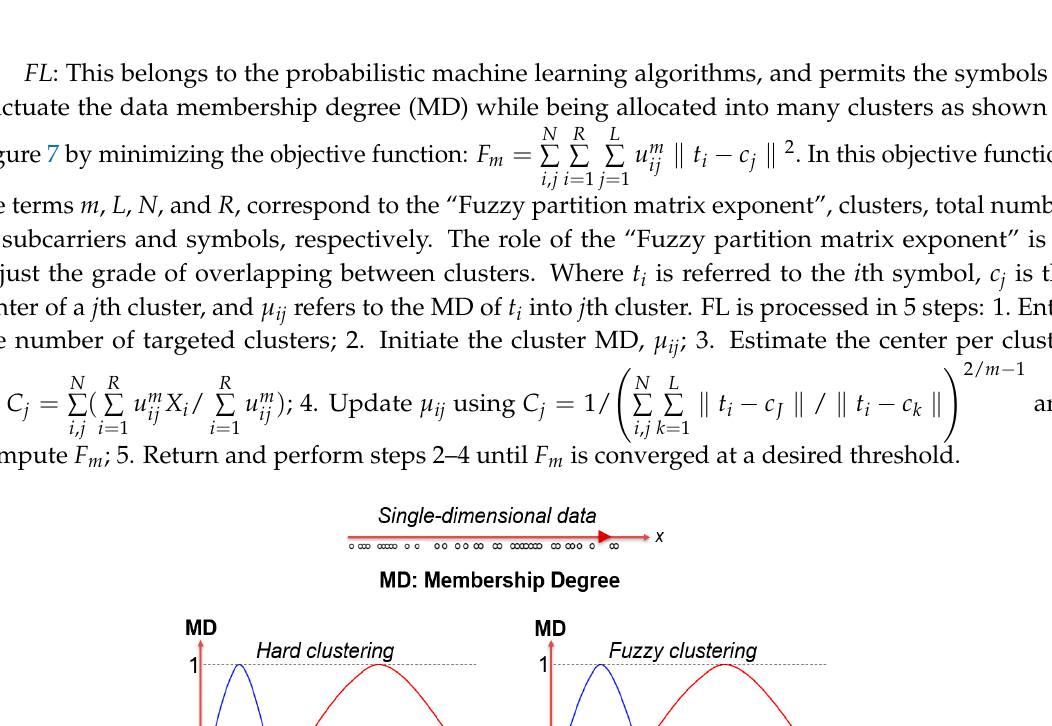
Figure 7 by minimizing the objective function: 𝐹